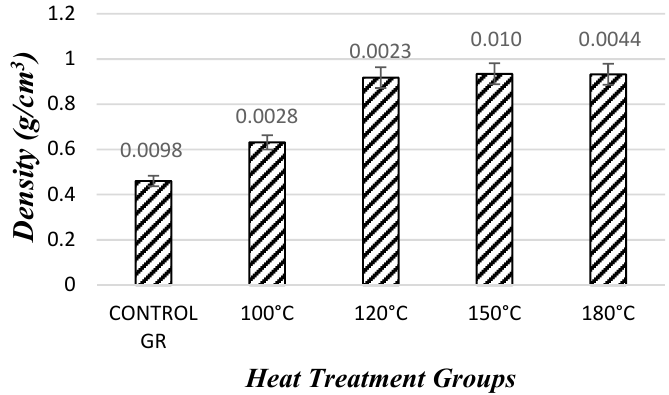
Figure 8. Density values of the samples after the densification process.